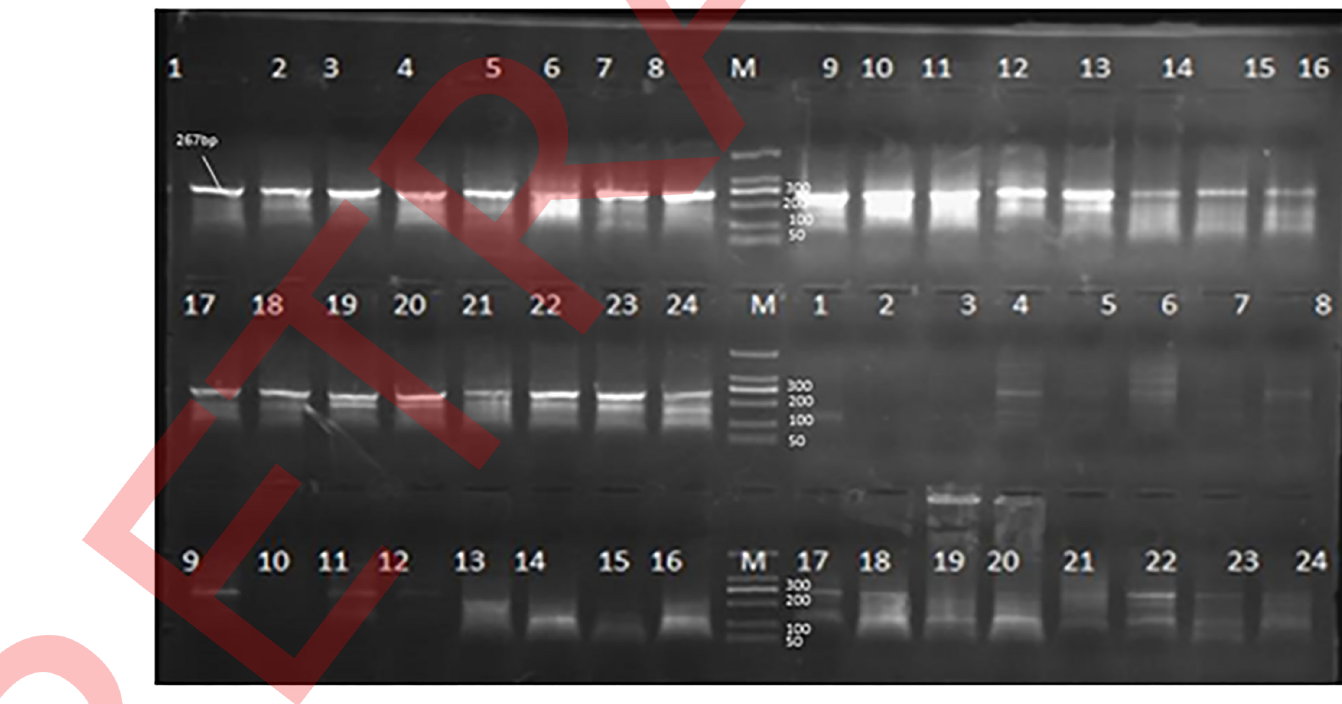
Fig 1. Depicted accession in study for C -T